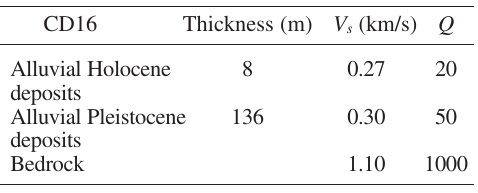
Table IV. Velocity model for CD16.